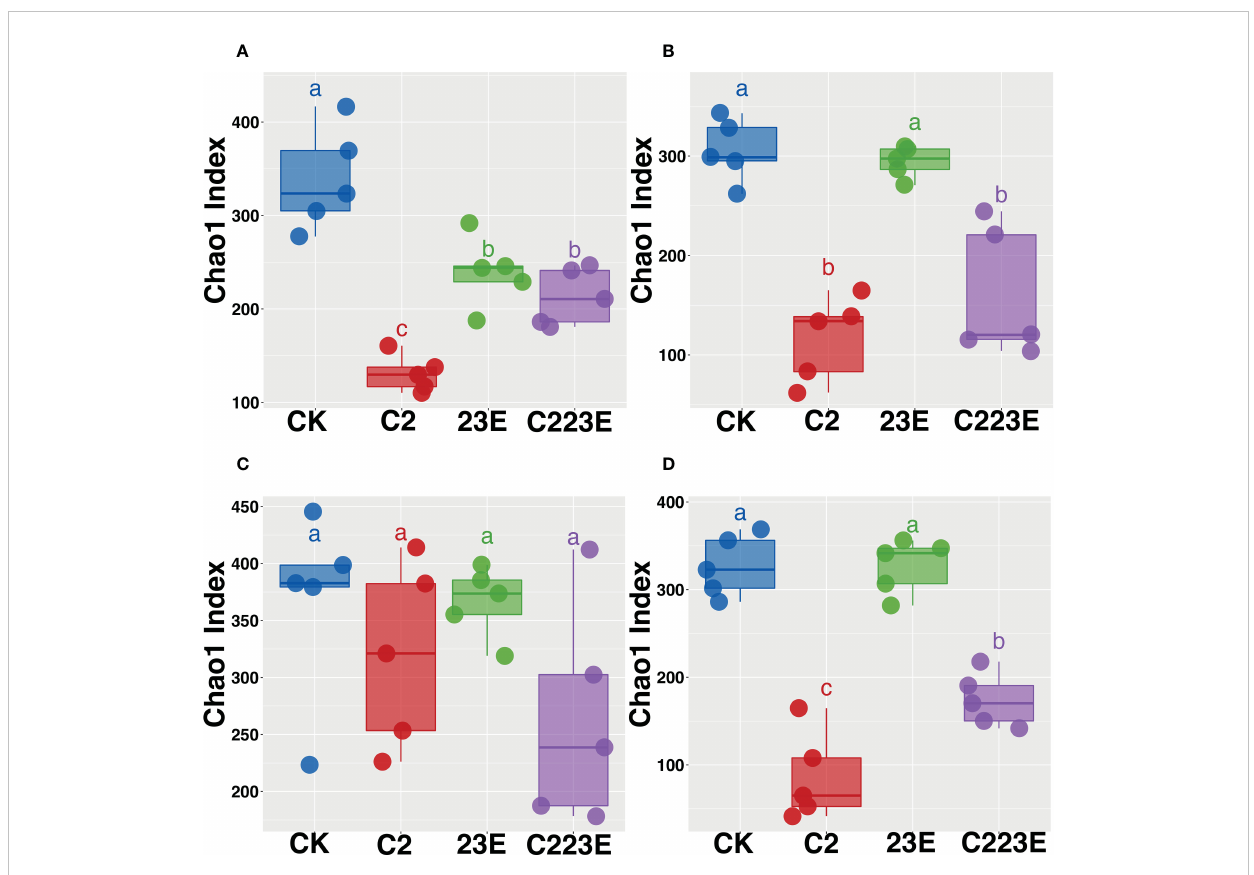
FIGURE 2 Effects of phage combination on the alpha diversity of epiphytic (A, B) and endophytic (C, D) bacterial communities. Alpha diversity is characterized based on the Chao1 index. Based on the Kruskal-Wallis test, different letters indicates signi fi cant differences at P < 0.05. CK, Control; C2, Xoo strain alone; 23E, Xoo phages (J2+J3+E); C223E, Xoo strain C2 + Xoo phages